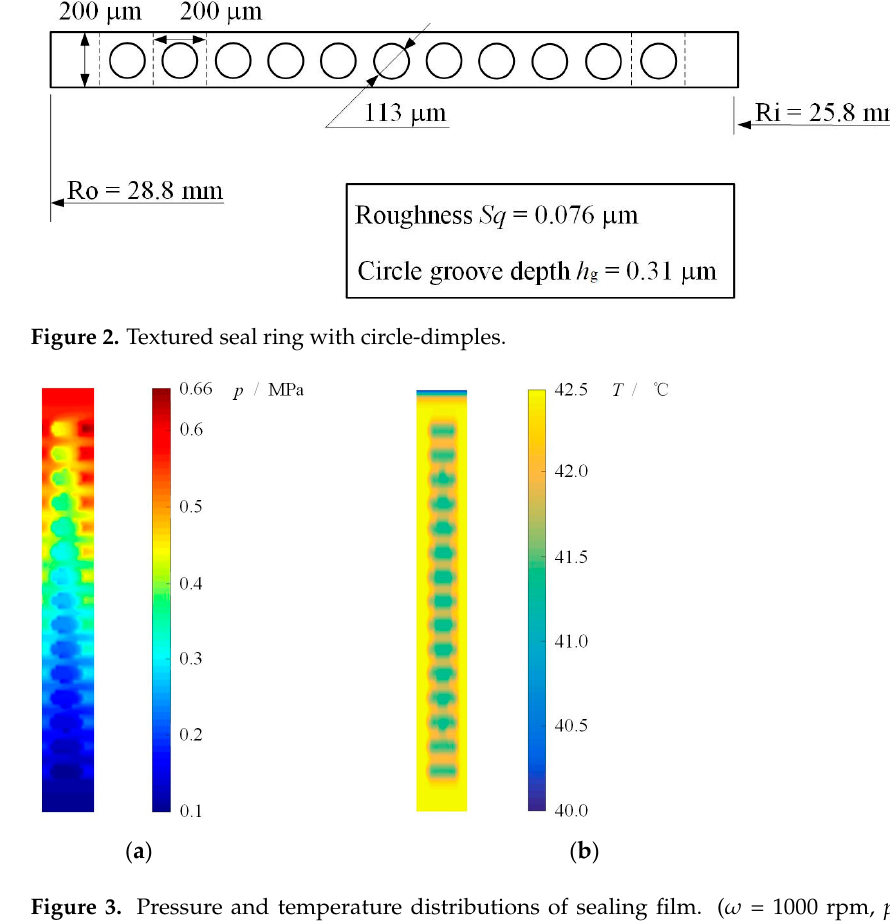
Figure 3. Pressure and temperature distributions of sealing film. ( ω = 1000 rpm, p o = 0.6 MPa, p i = 0.1 MPa). ( a ) Pressure distribution, ( b ) Temperature distribution.